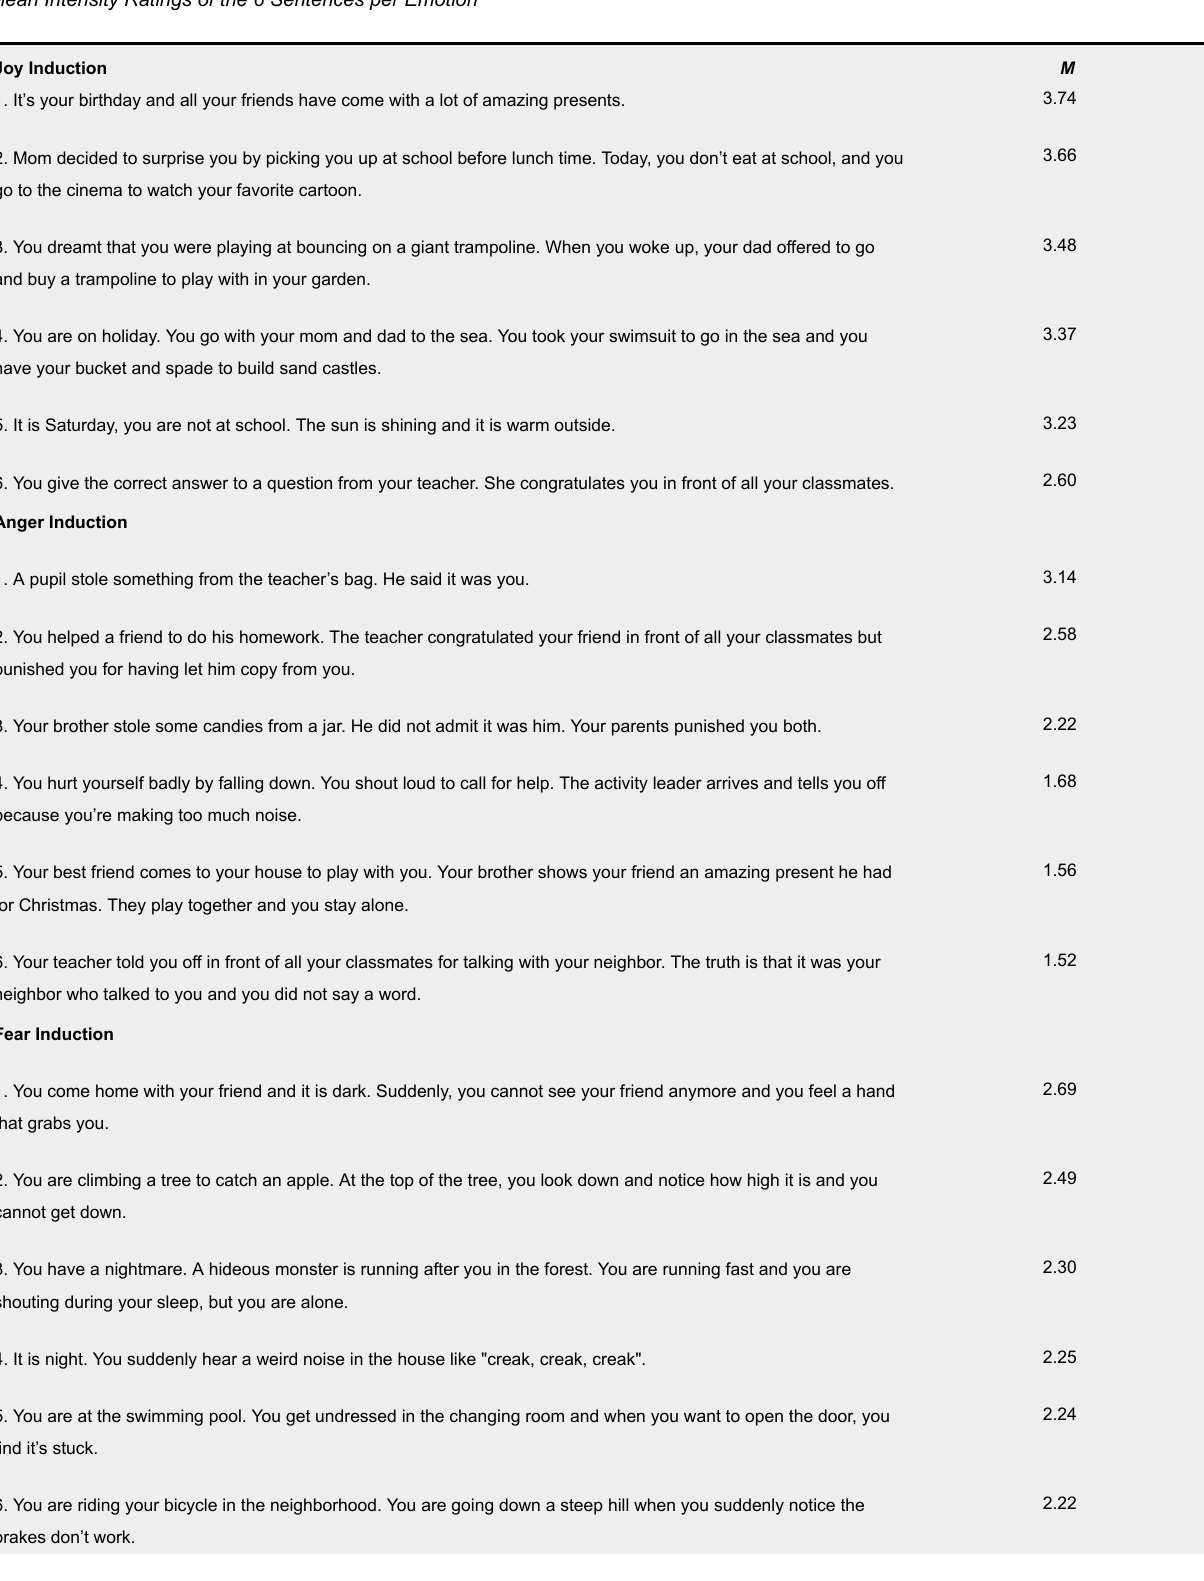
Mean Intensity Ratings of the 6 Sentences per